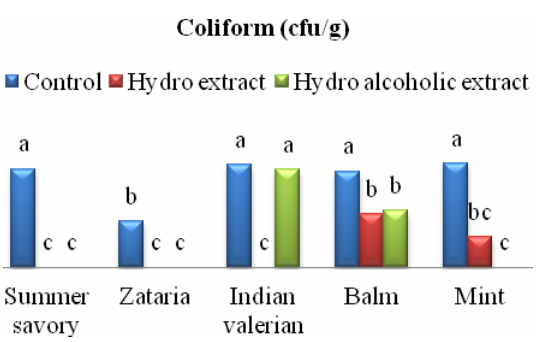
Fig. 3. Mean comparison of Coliform in hydro and hydro alcoholic extract